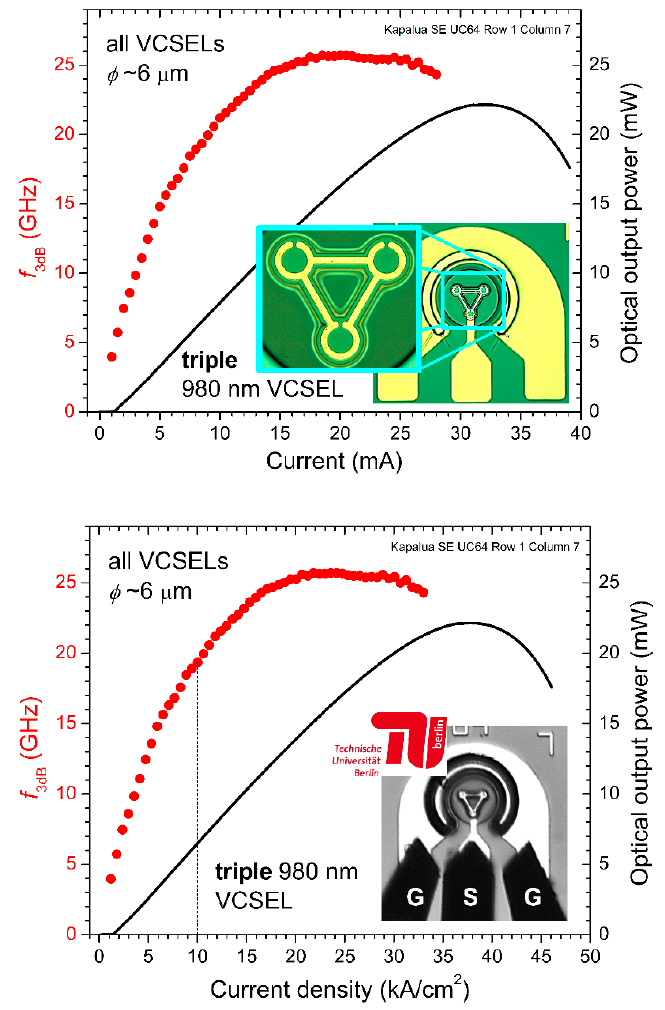
Figure 9. Measured − 3 dB small-signal modulation bandwidth ( f 3dB ) versus direct current (DC) bias I (upper plot) and versus J (lower plot) for a 980 nm triple VCSEL array with φ ~6 µ m.